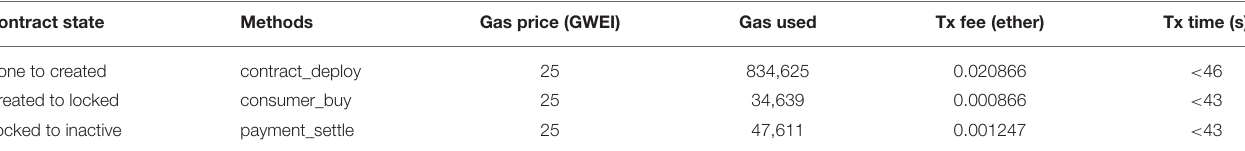
Table 3 | Transaction cost for a smart contract